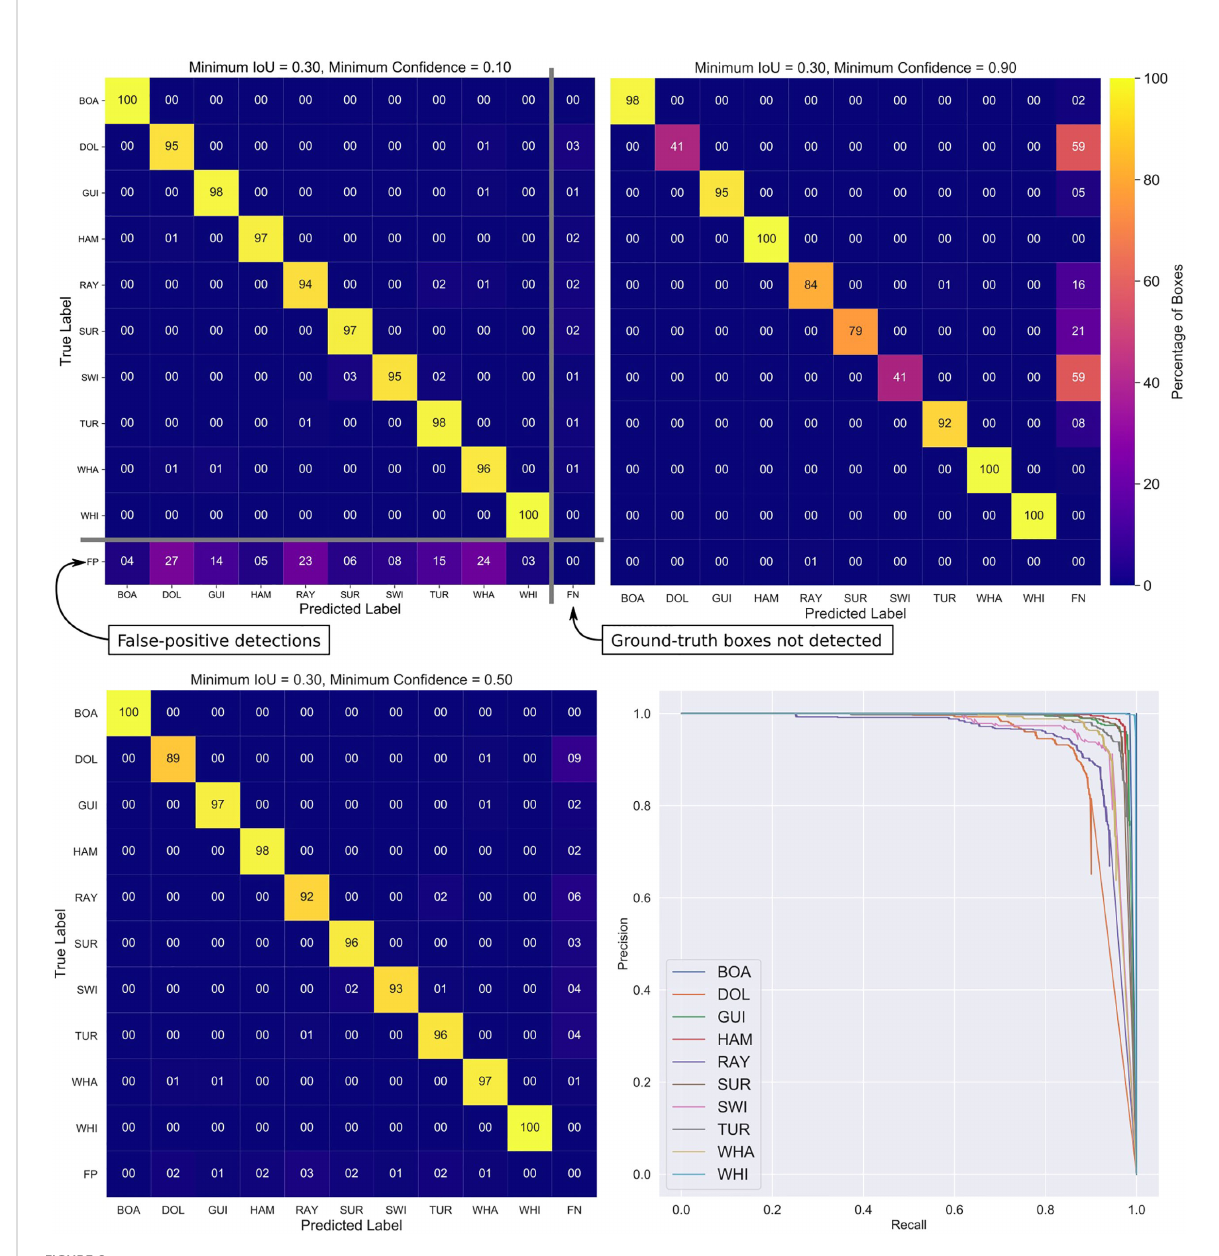
FIGURE 8 Top row & bottom-left panel: Three confusion matrices for the fi nal ResNet-50 backbone model created at con fi dence score thresholds of 0.1, 0.5 and 0.9. A common IoU threshold of 0.3 was used to cross-match ground-truth and detection boxes. The model was tested against an unseen internal test set randomly split from the ensemble data. Each row in the matrix encodes how ground-truth labels (y-axis) were predicted by the classi fi er (x-axis). The prominent diagonal shows that most objects were detected and labelled correctly. Off-diagonal elements show when a particular class is mislabeled as another - an important diagnostic of why a model is failing. The bottom row of the matrix encodes false-positive (spurious) detections, which are common when the score threshold is low. Note that the bottom row can have percentages greater than 100, meaning that there are greater numbers of false-positives than ground-truth boxes. The right-most column shows false negative detections - real objects that were missed by the algorithm. These are common when the con fi dence threshold is high as the model rejects a high fraction of candidates. All rows, except FP, add to 100 percent. The mean average precision for the best fi tting model is mAP = 0.96. Bottom-right panel: Precision-Recall curves broken down by class. The area under each curve gives the average precision for each